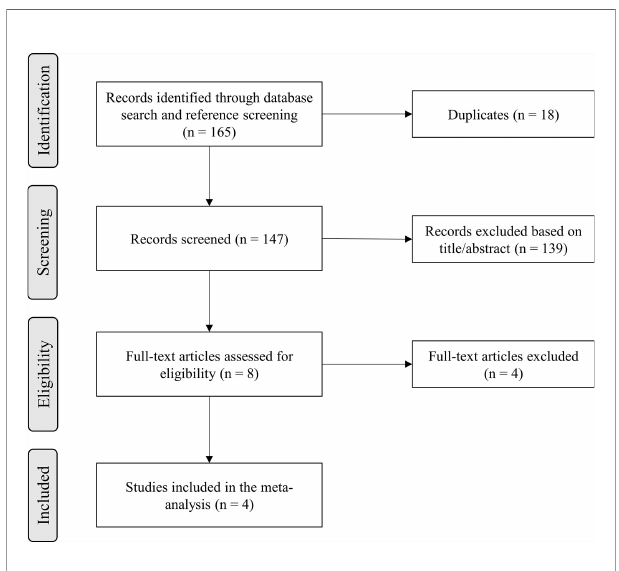
FIGURE 1 | Flow-chart of study